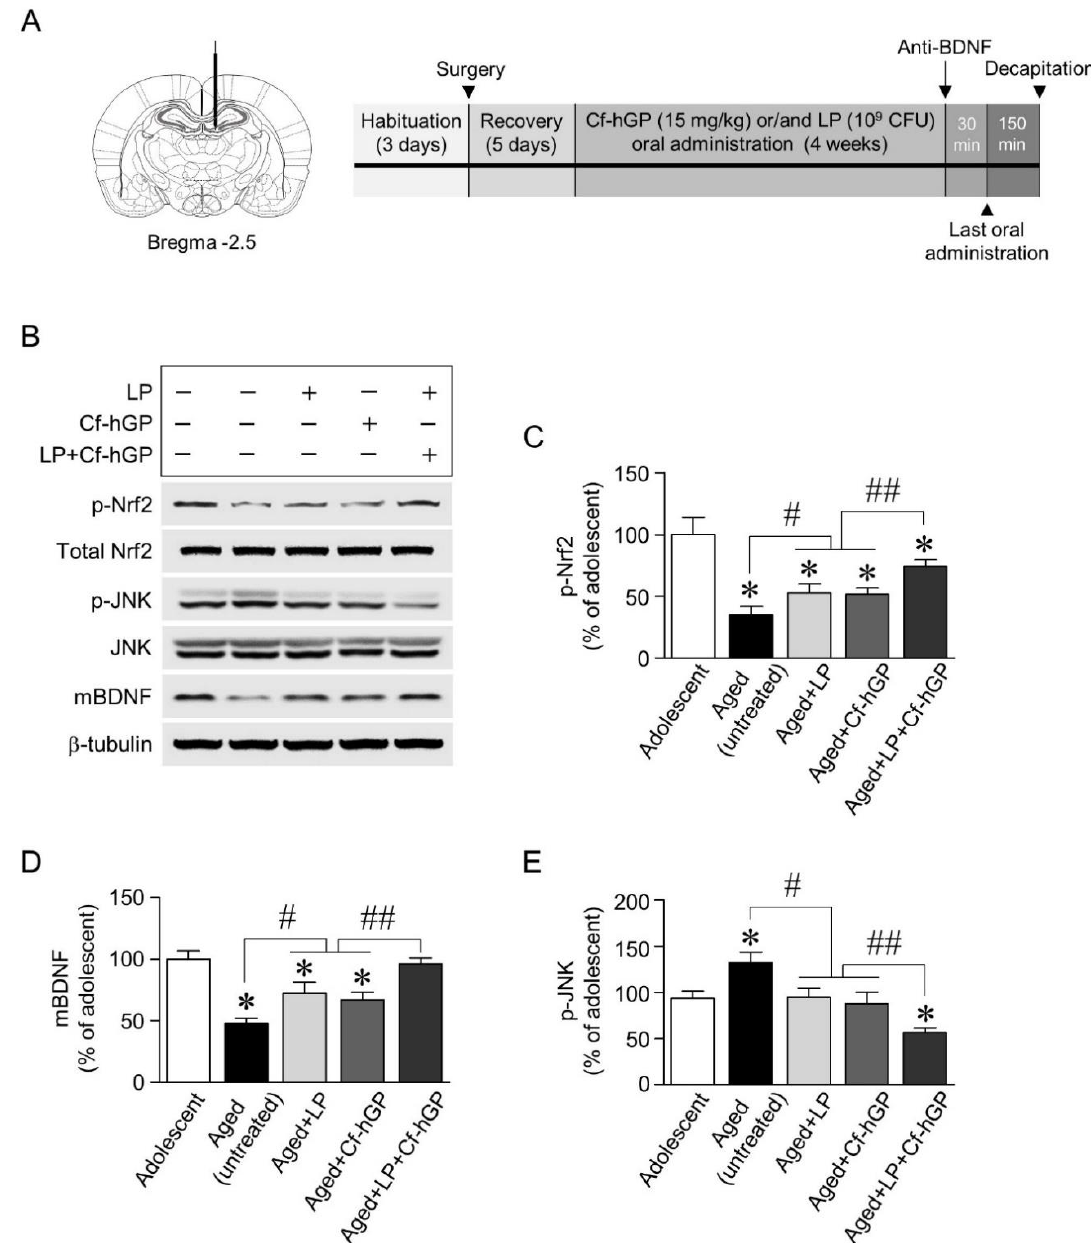
Figure 2. Expression of mature BDNF and phosphorylation of nuclear factor erythroid 2-related factor 2 (Nrf2) and c-Jun N-terminal kinase (JNK) in the dorsal hippocampus by co-treatment with Cf-hGP and L. plantarum . Following oral administration of Cf-hGP (15 mg / kg) or L. plantarum (10 9 CFU / rat / day) once a day for 4 weeks, expression of mature BDNF (mBDNF) and phosphorylation of Nrf2 and JNK in the dorsal hippocampus were measured by immunoblotting ( A , B ). The co-treatment with Cf-hGP and L. plantarum synergistically increased Nrf2 phosphorylation and mBDNF expression compared to mono-treatment, but JNK phosphorylation was decreased ( C – E ). * p < 0.05 versus adolescent rats; # p < 0.05 versus aged untreated rats; ## p < 0.05 versus the rats treated with only Cf-hGP or LP. Cf-hGP, Capsosiphon fulvescens glycoprotein; LP, Lactobacillus plantarum ; p-Nrf2, phosphorylated Nrf2; p-JNK, phosphorylated